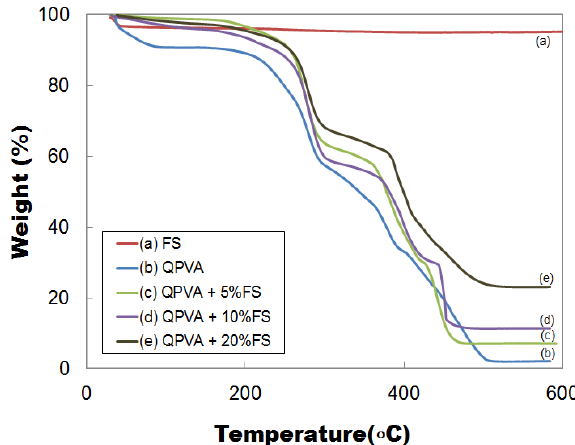
Figure 4. TGA graphs of ( a ) Fumed silica; ( b ) QPVA; ( c ) QPVA/5% FS; ( d ) QPVA/10% FS and ( e ) QPVA/20% FS.